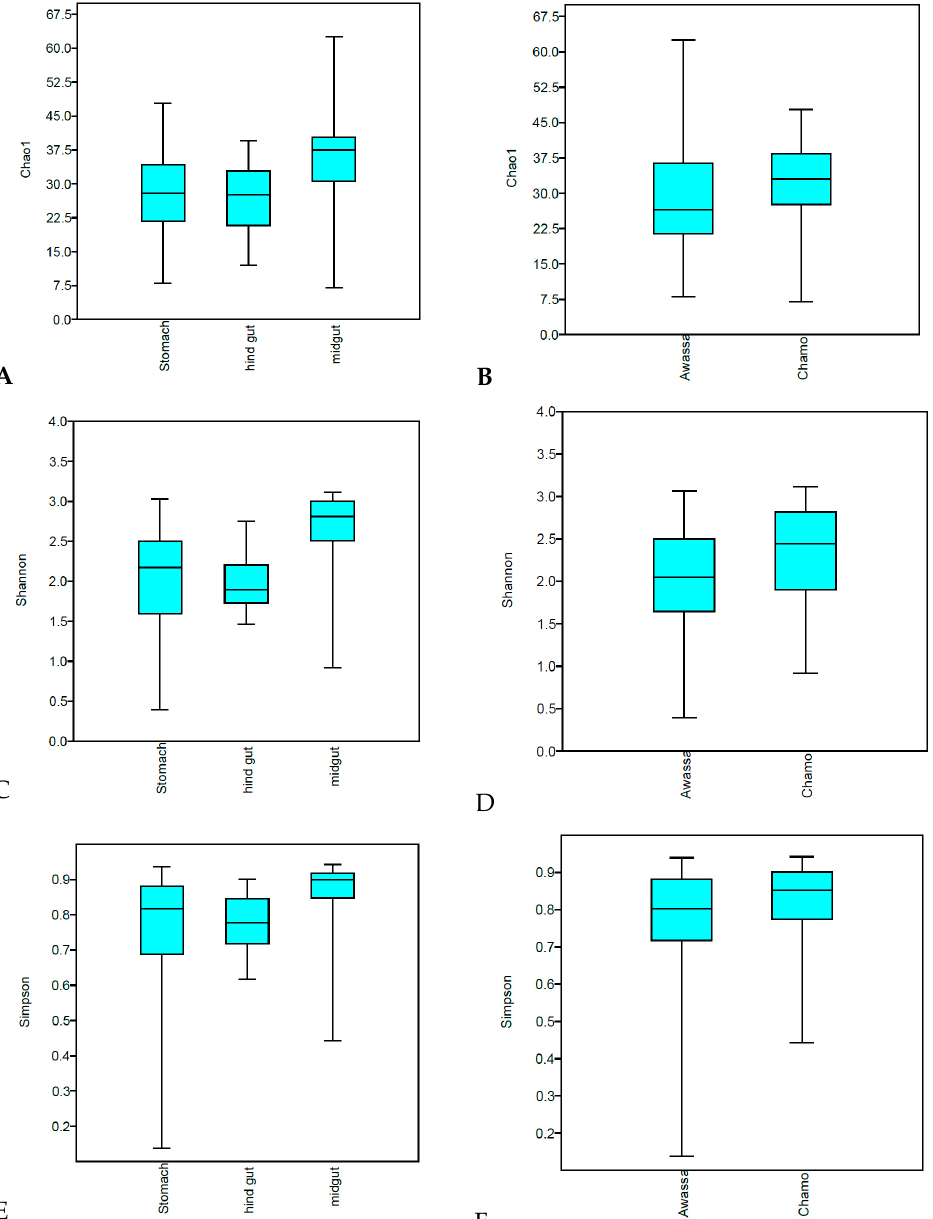
Figure 3. Alpha diversity of gut microbiome from Nile tilapia. ( A ) Chao1 of the gut regions. ( B ) Chao1 of the two lakes. ( C ) Shannon index of the gut regions. ( D ) Shannon index of the two lakes. ( E ) Simpson index of the gut regions. ( F ) Simpson index of the two lakes.